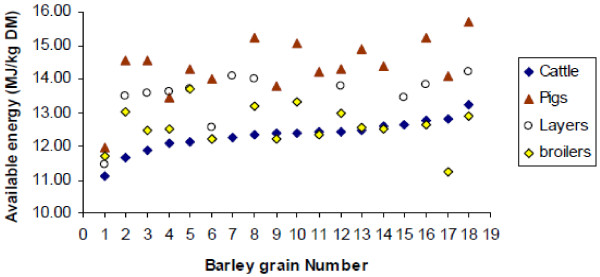
Available energy for 18 samples of barley fed to livestockad libitum(Adopted from[10]).